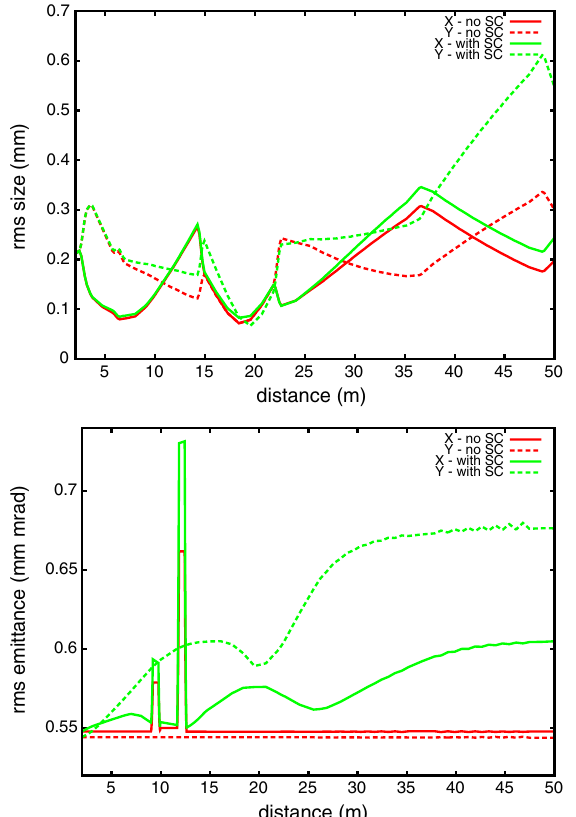
FIG. 5. Evolution of transverse rms sizes (top) and transverse rms emittances (bottom) without (red) and with (green) space- charge effects in the simulation.